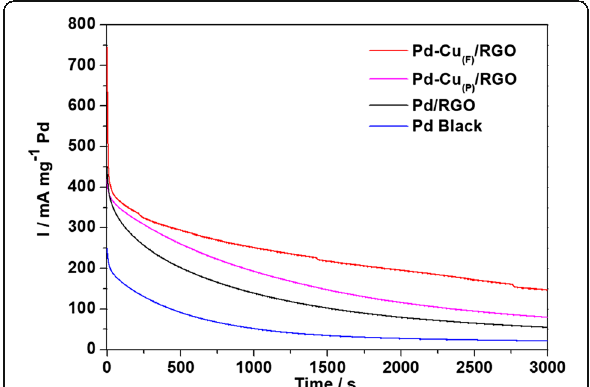
Fig. 8 I - T curves of the Pd-Cu (F) /RGO (curve a), Pd-Cu (P) /RGO (curve b), Pd/RGO (curve c), and Pd black (curve d) in 0.5 M NaOH + 0.5 M C 2 H 5 OH up to 3000 s at 25